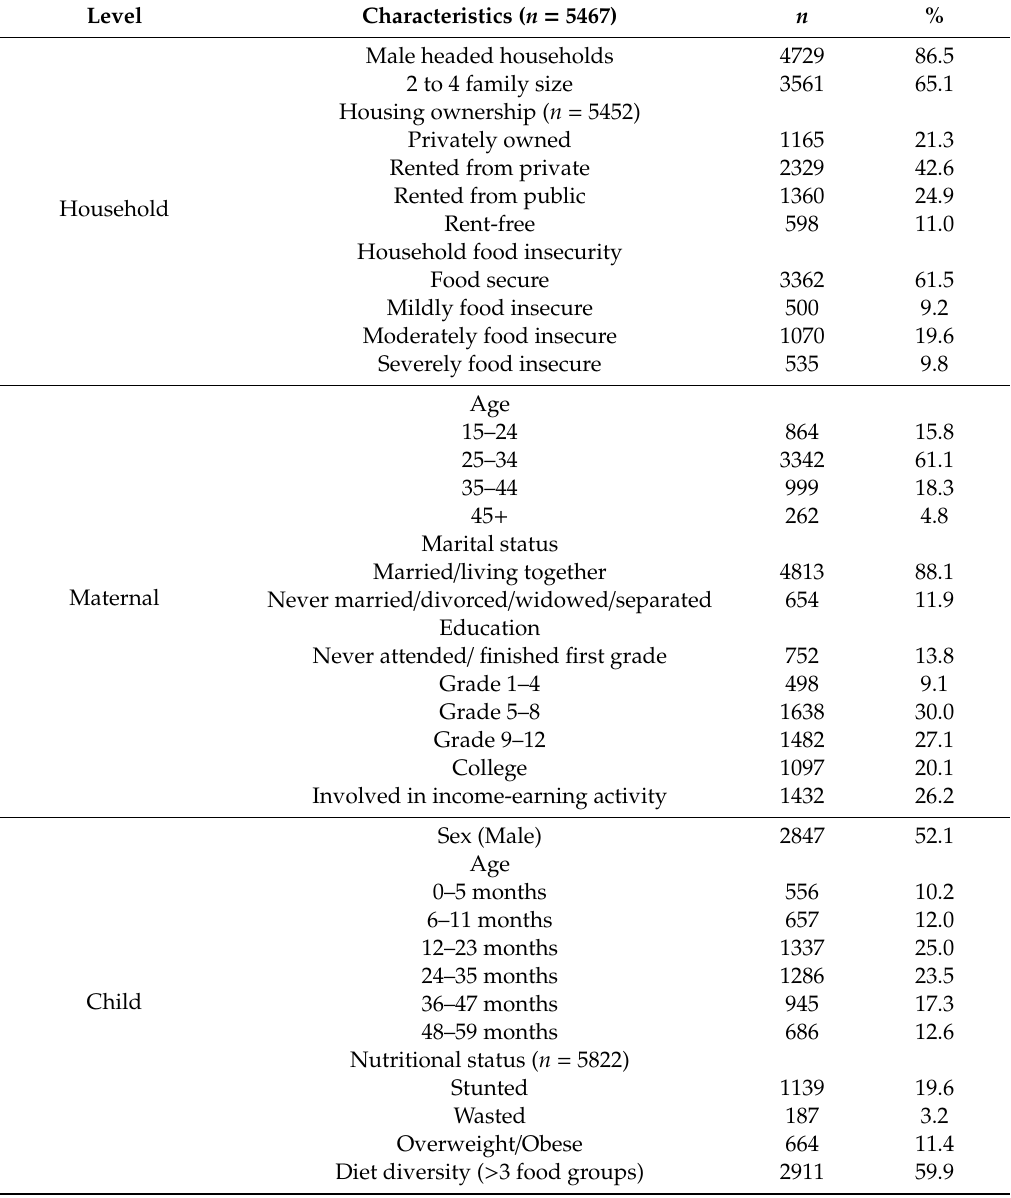
Table 1. General households, maternal and child characteristics in Addis Ababa,